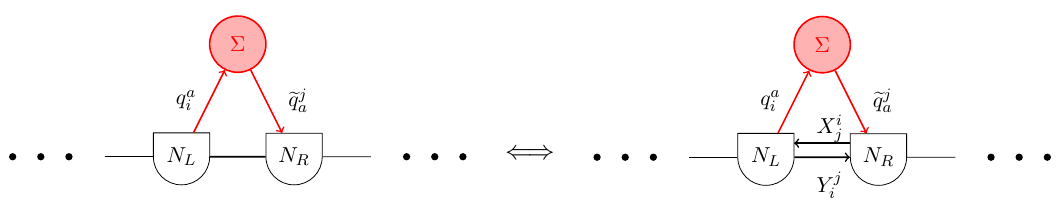
Figure 5 . The general form of a 3d-1d quiver that realizes a vortex defect in a 3d N = 4 quiver gauge